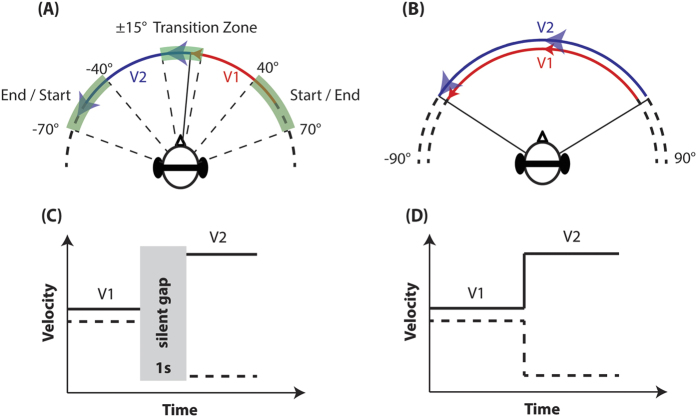
(A) Diagram showing the velocity contrast task design. Subject’s head remained stationary while the stimuli moved along the frontal audio-visual horizon, using virtual auditory space. The start and end points were ±40–70°, depending on velocity, with a ±15° transition zone in the middle. There were two stimulus intervals along the movement trajectory that had different velocities, V1 and V2 (marked red and blue). In an increase condition, V2 > V1, and V2 < V1 in a decrease condition. (B) An example of a velocity discrimination task design that is used in previous studies. Unlike a velocity contrast task (A), the two stimulus intervals in (B) travel along similar trajectories (marked red and blue), separated in time by an inter stimulus interval (ISI). (C) Velocity profile of the discontinuous condition. The two intervals (V1 and V2) are separated in time by a 1 second gap of silence; this is identical to the ISI used in Carlile and Best8. (D) Velocity profile of the continuous condition. The two intervals (V1 and V2) are continuous in time (and space).